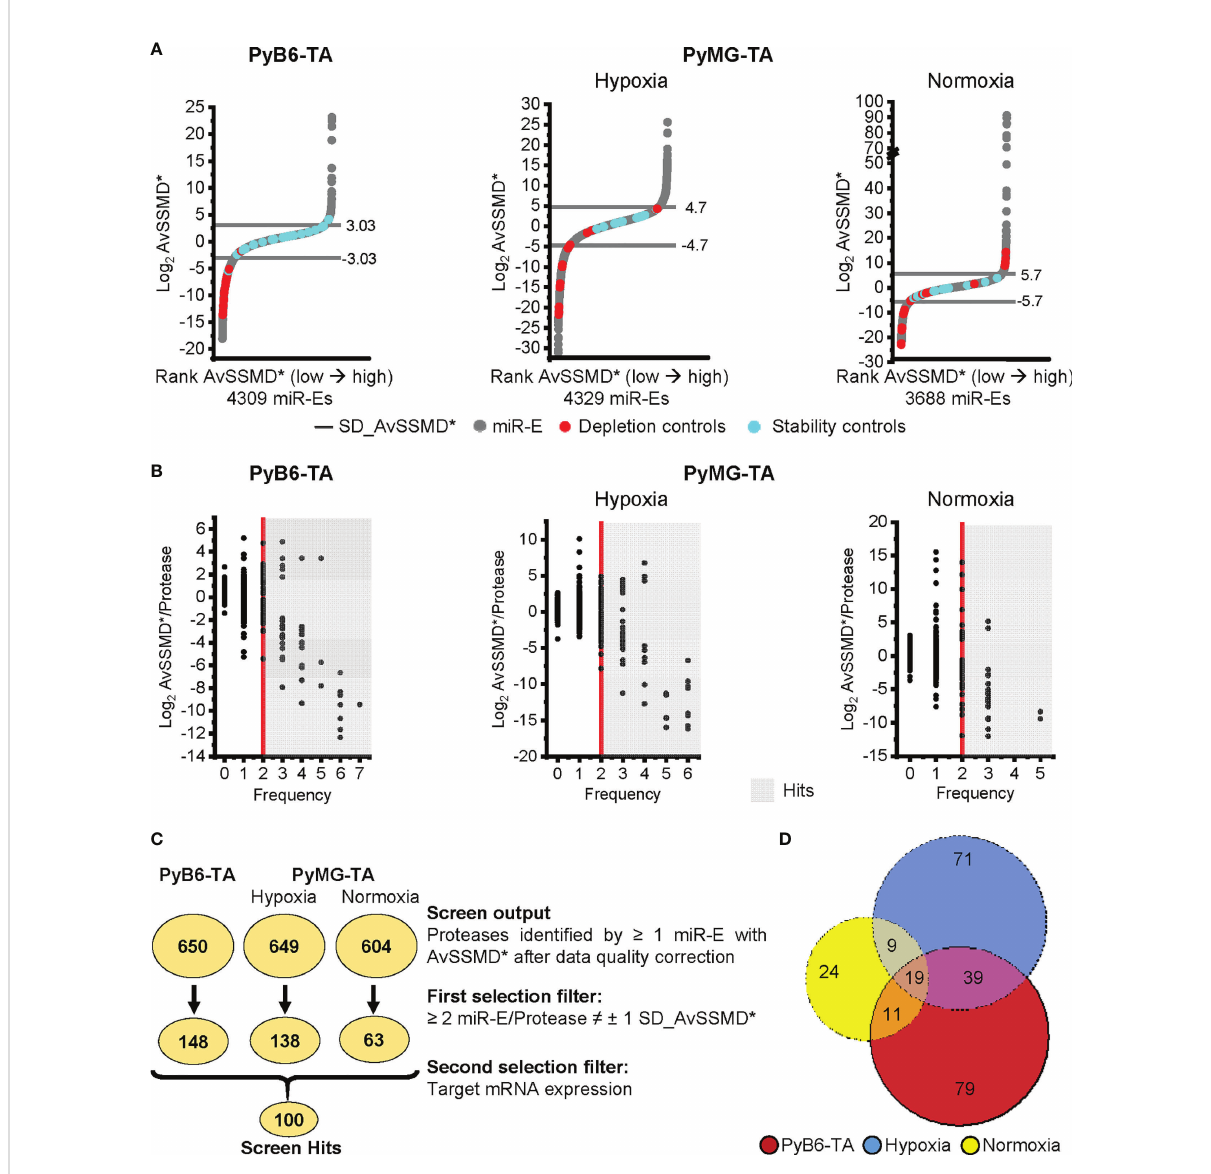
FIGURE 3 Competitive growth screen hit selection. (A) Distribution of Log 2 AvSSMD* effect scores for all miR-Es in the competitive growth screens. Cell lines and conditions as indicated. Rank AvSSMD*: values ranked by size. Gray: Log 2 AvSSMD* score of one miR-E. Blue: shRenilla/-Luciferase stability controls. Red: shRpa3-218/-Rpa3-457 depletion controls. Horizontal line: ± 1 SD_AvSSMD* of all miR-Es in the screen. (B) Dual fl ashlight plots. Black dot: Protease identi fi ed by minimum 1 corresponding miR-E with successfully calculated AvSSMD* after complete processing of sequencing reads. The term protease referred to all degradome-encoded proteins including proteases, protease-like proteins, and protease subunits. Hits highlighted in gray [ ≥ 2 miR-E/Protease outside ±1 SD_AvSSMD* (Frequency)]. (C) Summarized hit selection with number of identi fi ed proteases in circles according to the indicated criteria. ≠ : outside. Searchable Excel fi le with the screen output and fi rst selection fi lter hits in Supplementary Tables S1 and S2. (D) Venn diagram of the hits from the fi rst selection fi lter (252 proteases in total). Searchable Excel fi le with the input of the Venn diagram in Supplementary Table